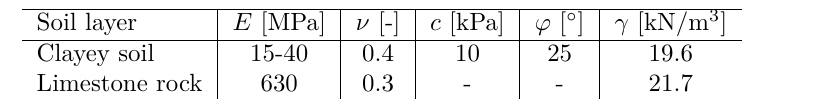
Table 1. Material parameters of subsoil layers.